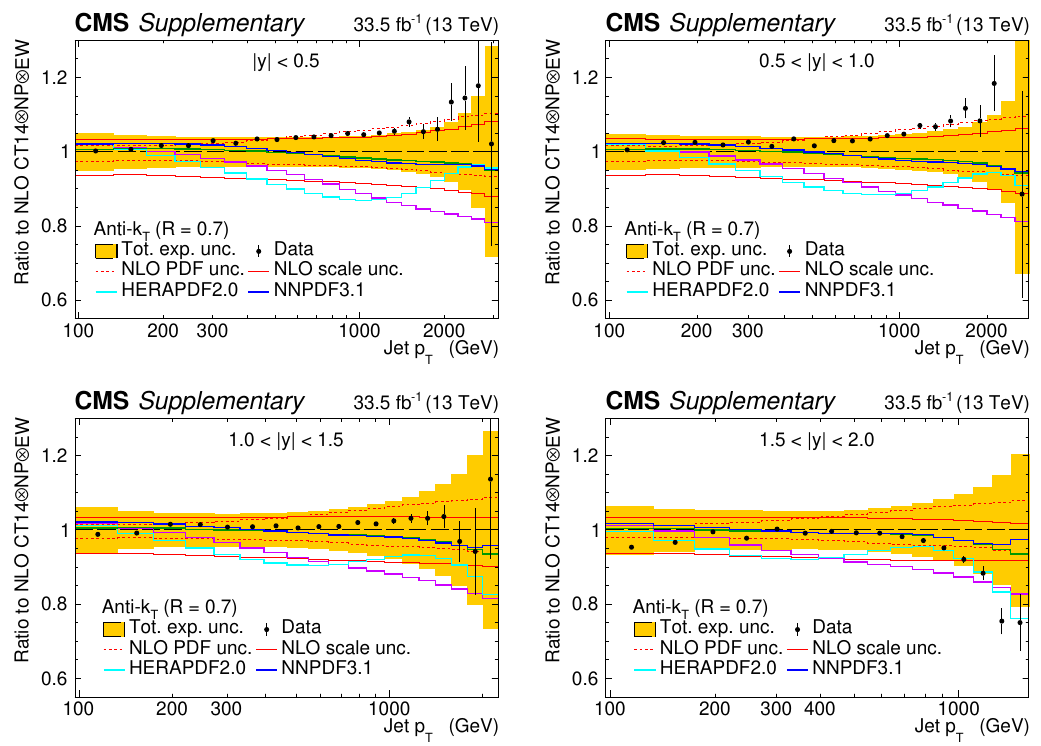
Figure 23 . Same as figure 21 for the distance parameter R = 0 . 7